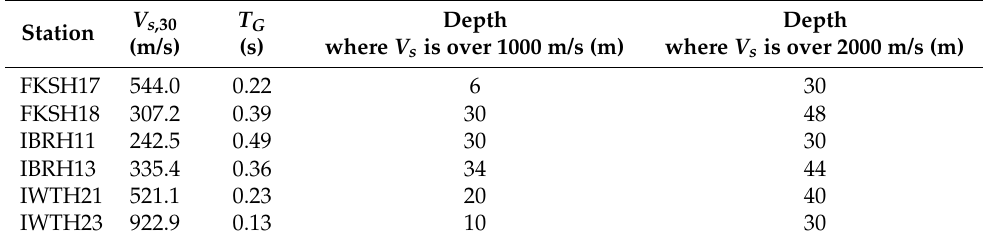
Table 1. Average shear wave velocity and natural period for each